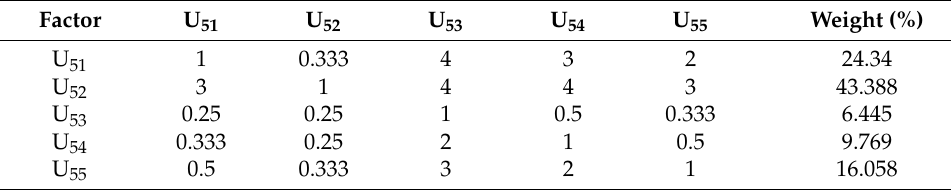
Table 9. Judgment matrix of SZSOJ’s second-level evaluation factors (U 5 ).